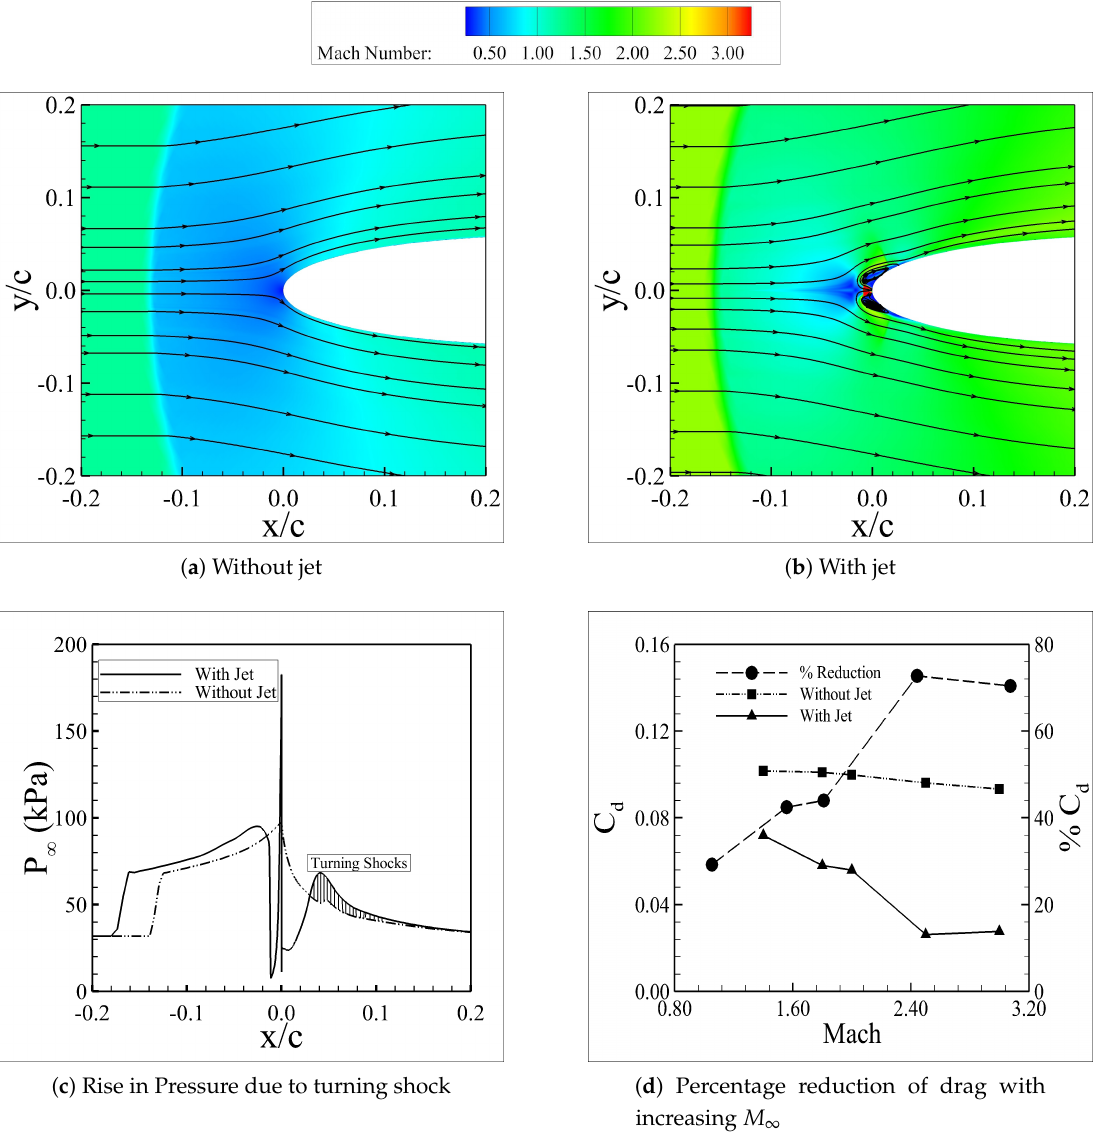
Figure 7. Comparison of stream lines for Mach contours between with and without jet